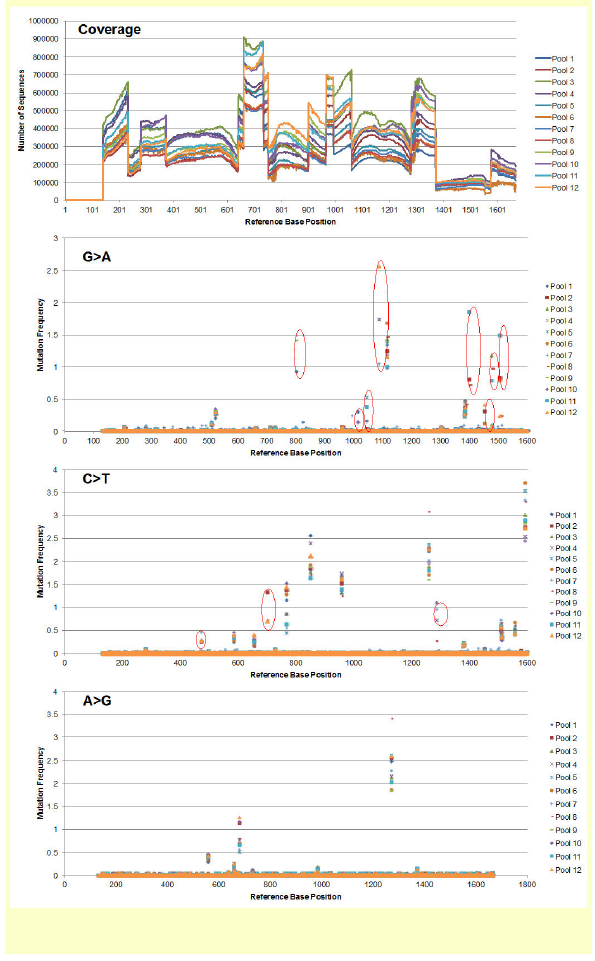
Figure 1. Sequencing read depth and mutation frequencies identified in 384 lines of the B. napus population. The top panel represents the coverage of Illumina read depth (vertical axis) across the four amplicons developed for the target gene (bn1); a total of 1,530 bp (horizontal axis). The second, third and bottom panels represent the frequency (vertical axis) of candidate mutations (C to T, G to A, and A to G, respectively) identified in three pools (circled in red) of the 12 pools used in the analysis across the length of the target region in base pairs (horizontal axis). No A to G mutations were identified in the target locus and this is consistent with the mechanism of mutation induction by EMS.